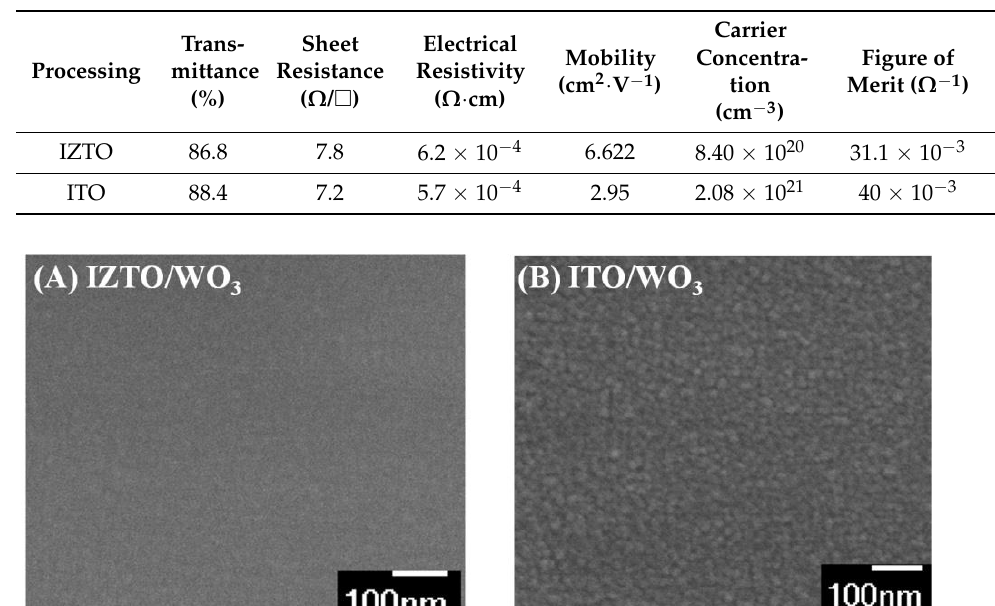
Figure 4. (A) SEM images of WO 3 /IZTO/glass and ( B ) SEM images of WO 3 /ITO films.